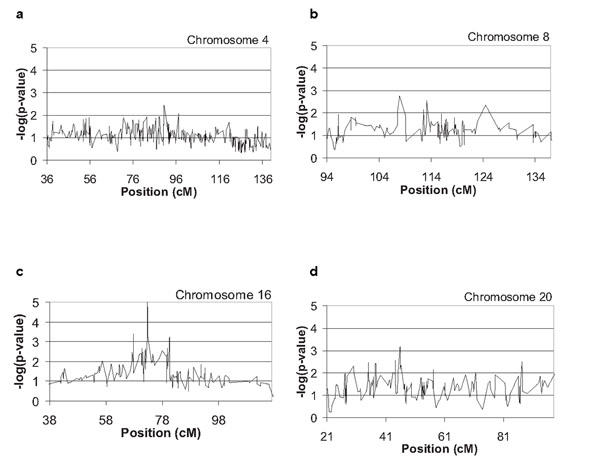
Selected region after second step of analysis for chromosome 4 (a), chromosome 8 (b), chromosome 16 (c), and chromosome 20 (d).